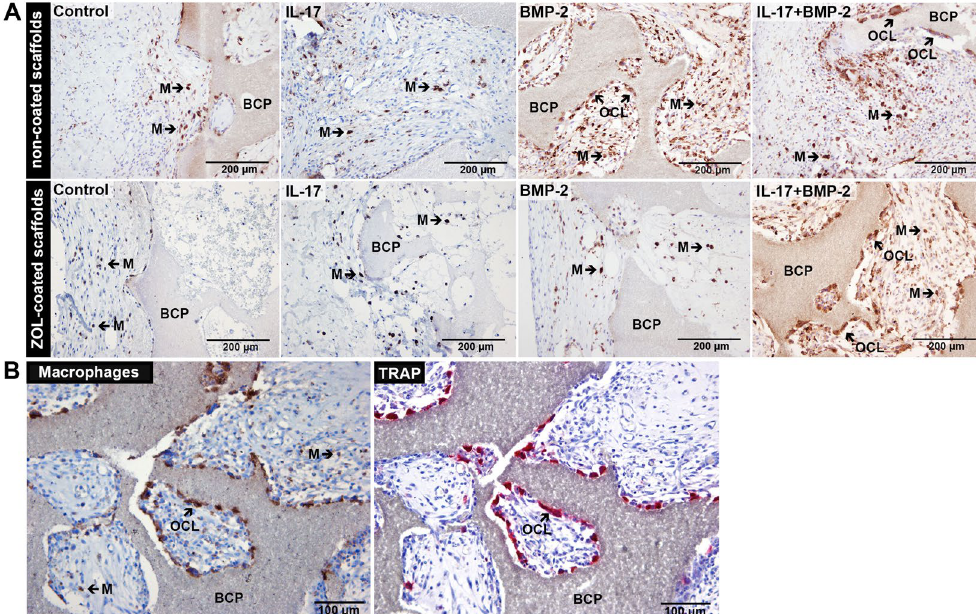
Figure 7. Presence of macrophages at day 10. Zoledronic acid (ZOL)-coated and non-coated biphasic calcium phosphate (BCP) scaffolds were loaded with BMP-2 (3 μ g/construct) and/or IL-17 (100 ng/construct) and implanted subcutaneously for 10 days. ( A ) Images taken from the edge of the constructs stained with the RAM11 antibody (brown) show the presence of connective tissue macrophages (M) and multinucleated cells resembling osteoclasts (OCL). ( B ) Consecutive sections showing the co-localization of multinucleated RAM11-positive and tartrate-resistant acid phosphatase (TRAP)-positive osteoclasts (OCL). Mononucleated RAM11-positive cells indicate connective tissue macrophages (M). Images are representative for BMP-2-loaded constructs without